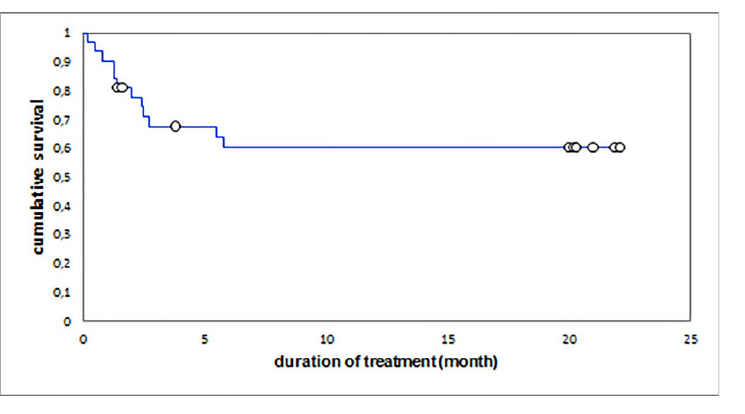
Fig 3. Global survival curve.